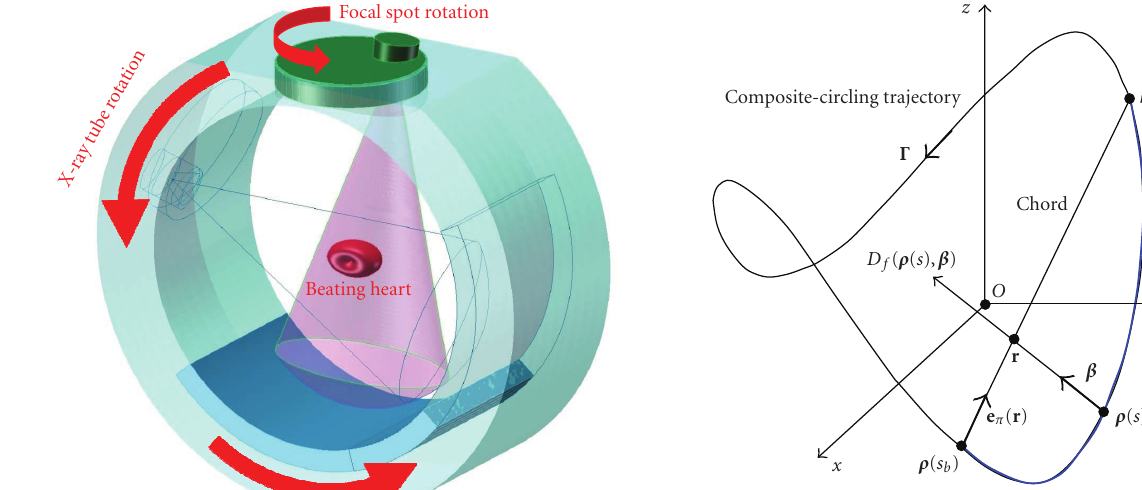
Figure 3: Concepts of the PI-Segment (chord) and associated PI-